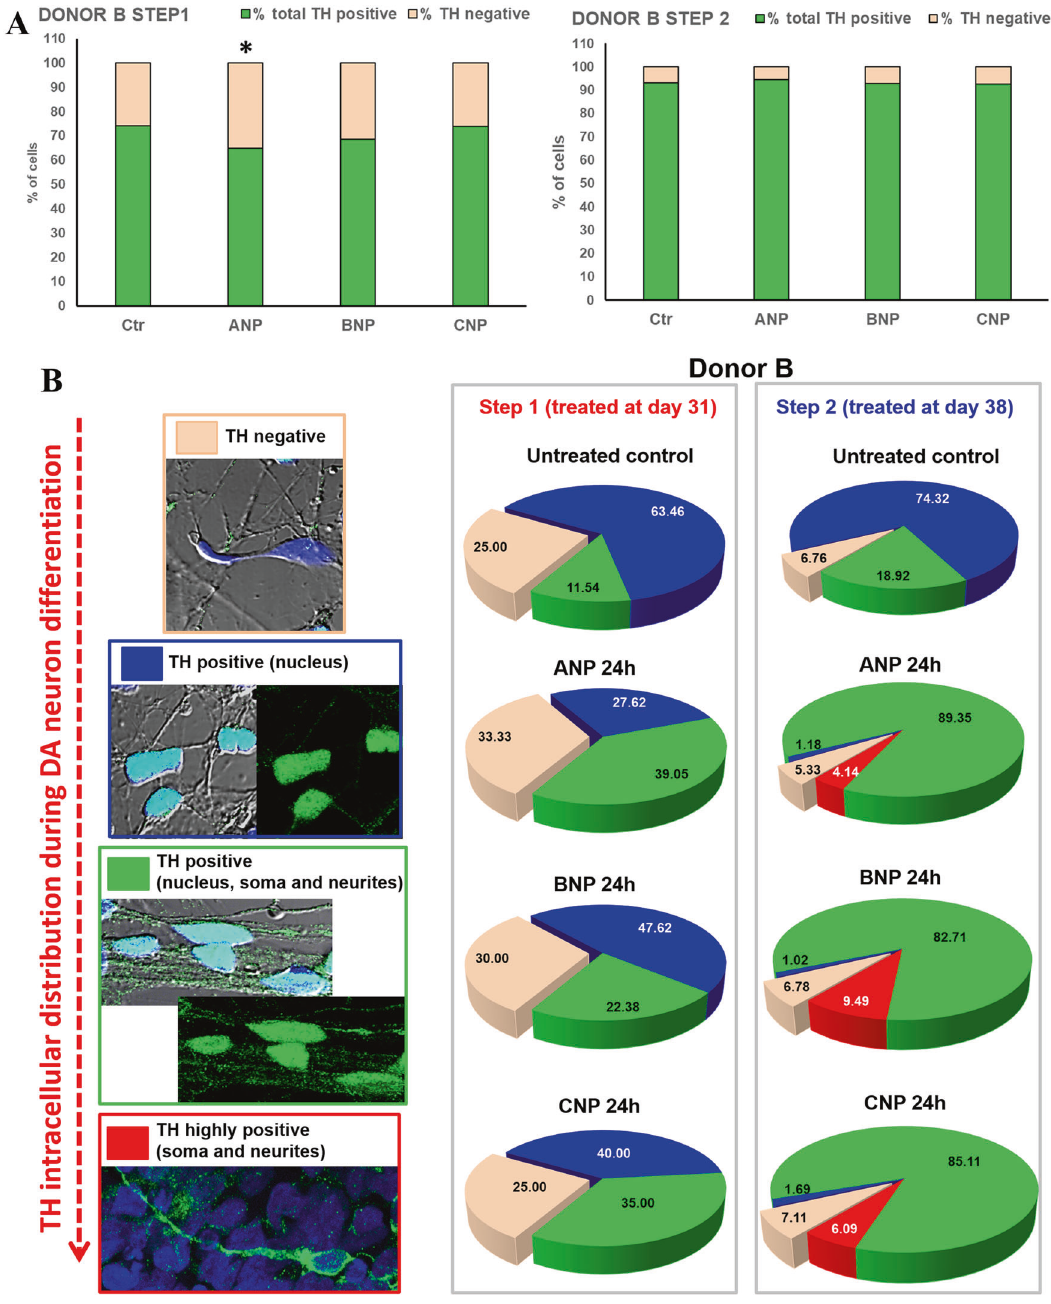
Fig. 8 NPs increase the proportion of DA neurons expressing TH in the soma and along the axons and neurites: hiPSCs-derived neuronal population obtained from DONOR B. A Quantitative evaluation of the percentage of TH + cells in cultures treated at day 31 (Step 1) or at day 38 (Step 2) with NPs, compared with the untreated controls. Data were obtained by counting a minimum of 300 cells/samples and results showed are the mean ± SD from three independent experiments ( n = 3). Signi fi cance vs. untreated control (two-tailed Student ’ s t test): * p < 0.05. B Left panels : representative images by confocal microscopy showing the modi fi cation of the intracellular distribution of total TH ( green hue ) observed during NPs-induced dopaminergic differentiation. Right panels : Quantitative evaluation of NPs effect on the percentage of TH − cells and of TH + neurons exhibiting this enzyme exclusively in the nucleus (poorly differentiated), in the nucleus, soma, and neurites (early differentiated) or exclusively in soma and neurites (mature DA increase of phosphorylation levels of TH at Ser40 and an increase of population from Donor B appeared morphologically and phenoty- DAT expression and/or glycosylation levels, and these effects, taken pically more differentiated than the neural population from Donor together, strongly suggest that the NPs stimulate the differentiation A, as suggested by the higher levels of total TH and of the of neuronal cells from both donors towards mature and functional glycosylated forms of DAT in the untreated controls form Donor B DA neurons. However, additional studies are needed to con fi rm the vs. controls from Donor A (Figs. 6C and 7C), and this could affect NP ’ s ability in promoting neural differentiation and maturation the quantity and the timing at which the effects were recorded. In towards the dopaminergic linage also in hiPSCs-derived lines any case, in both cell populations we recorded, on the overall, an